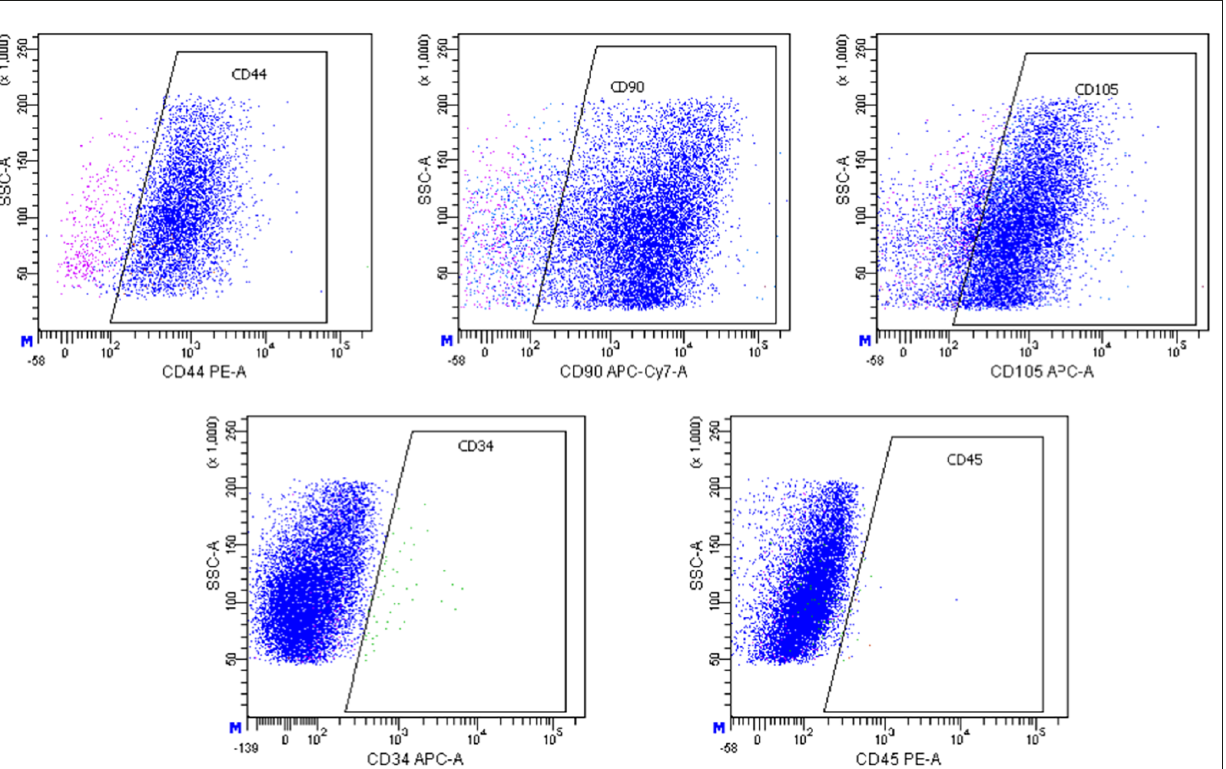
FIGURE1 Histograms of expression of CD44, CD90, CD105, CD34, and CD45 markers in the culture of murine ADSCs from young animals according to flow cytometry, the 2nd passage.